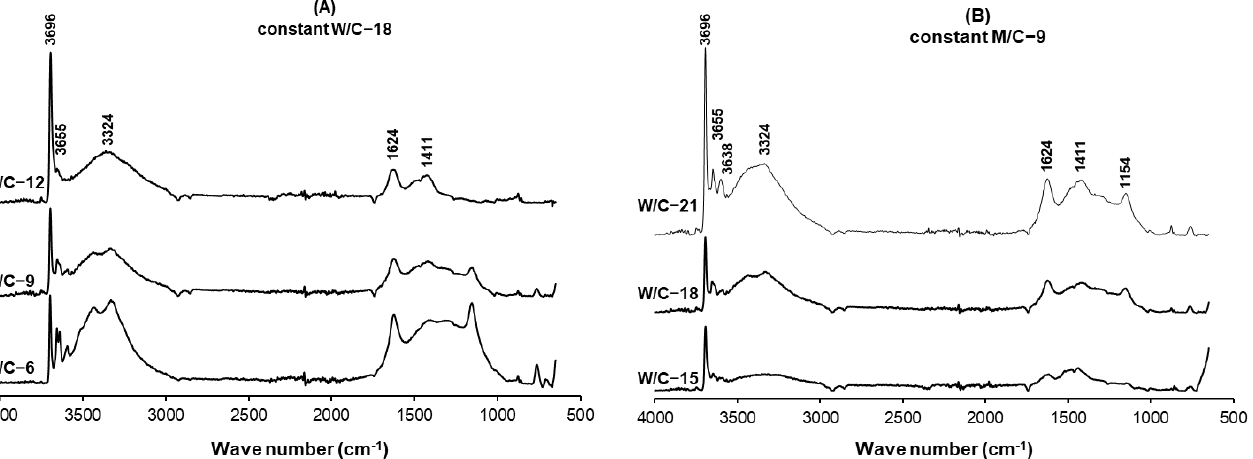
Figure 2. The DSC curves of the MOC binders with different molar ratios, ( A ) different MgO:MgCl 2 ratio, ( B ) different H 2 O:MgCl 2 ratio.